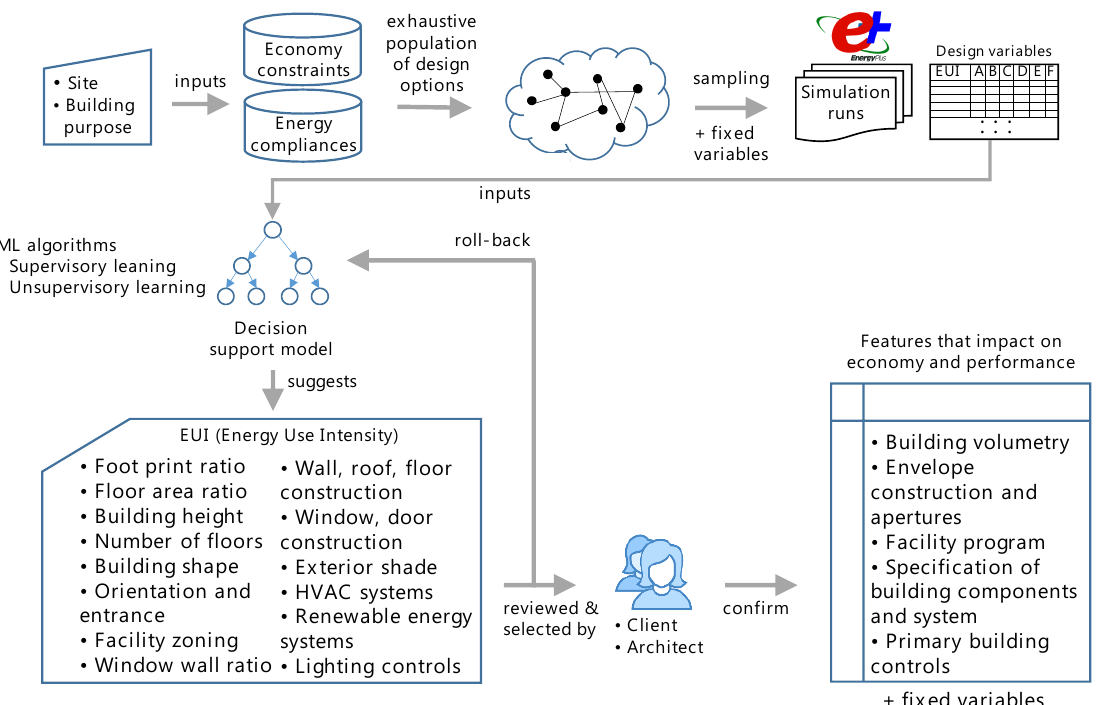
Figure 1. The EEB design decision support system at feasibility analysis stage.